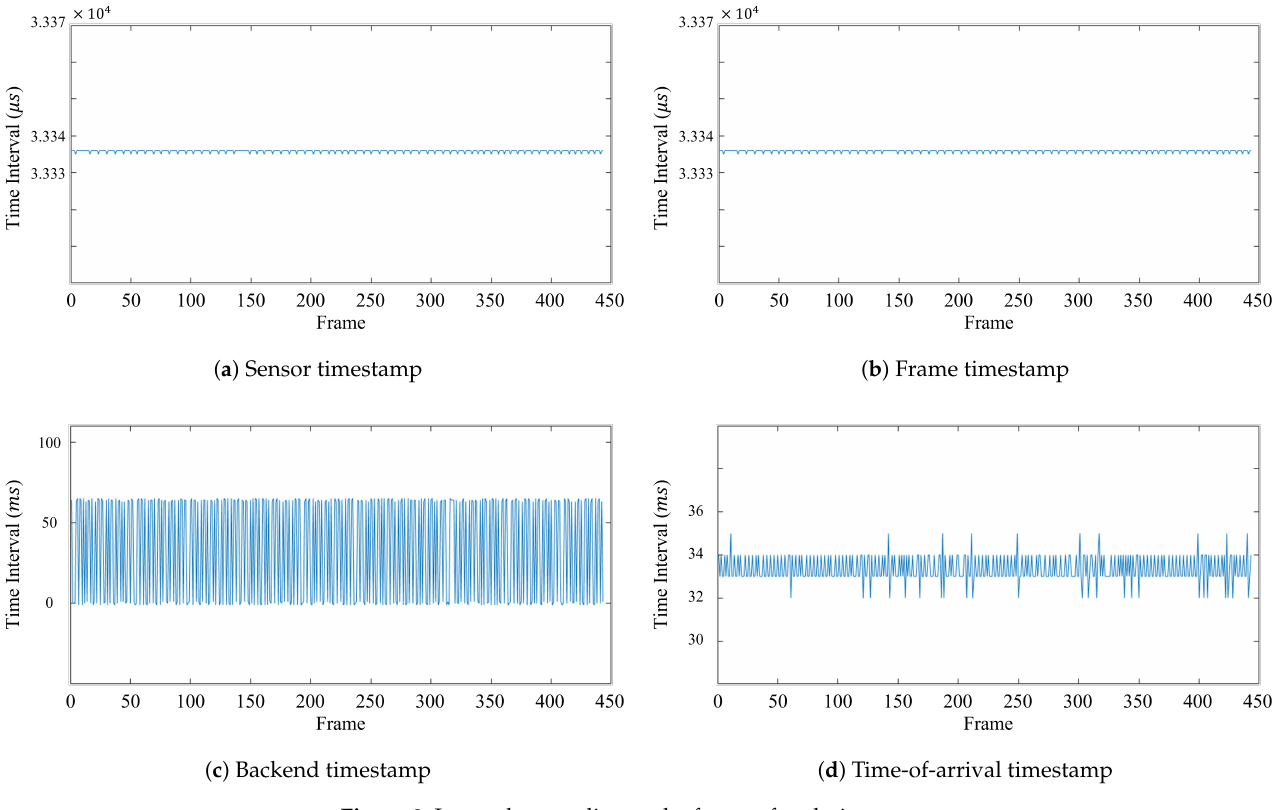
Figure 2. Intervals according to the frame of each timestamp.